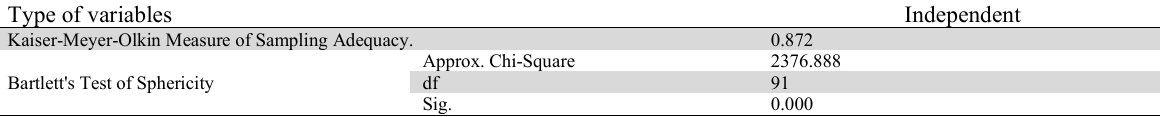
Correlation coefficients between variables EI Pearson Correlation